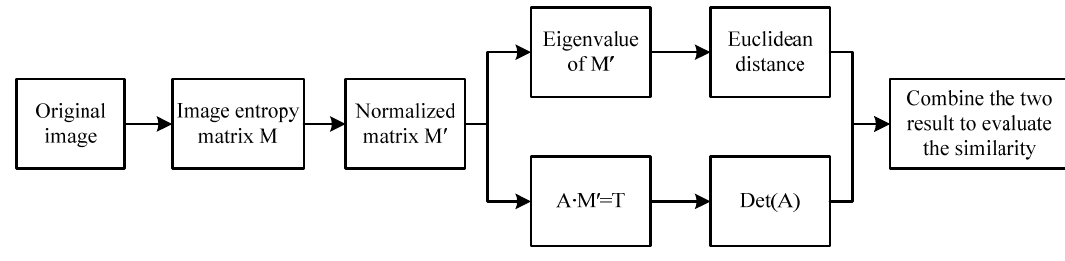
Fig. 5 Process of the feature extraction and matching